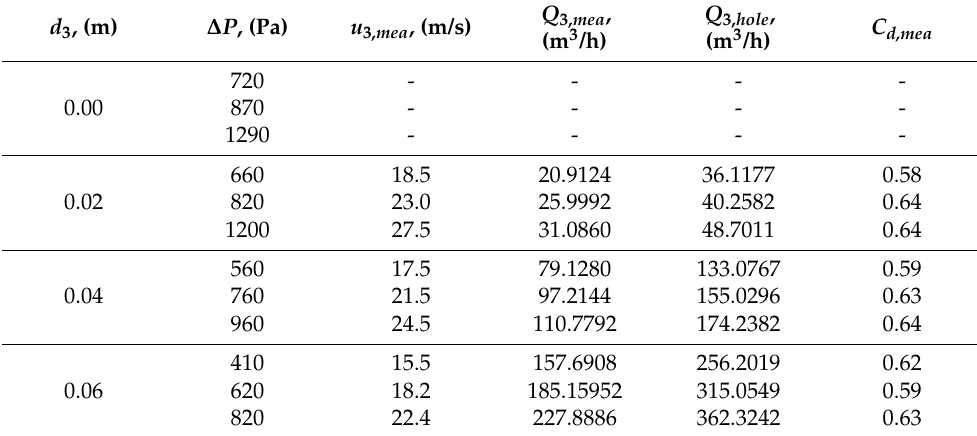
Table 3. Measurement results in the